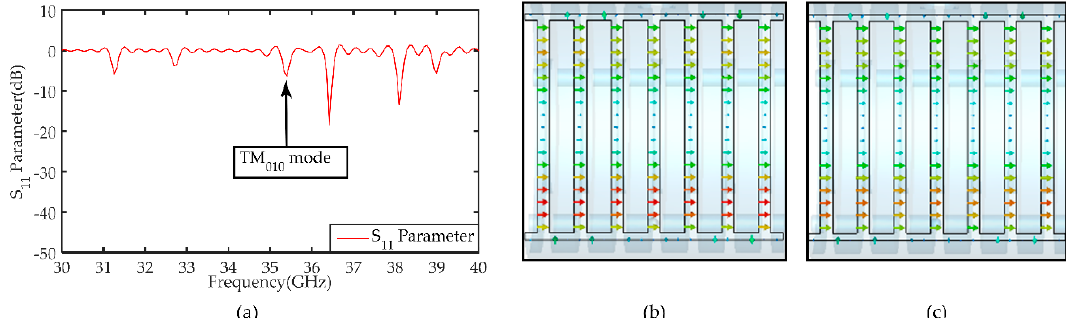
Figure 8. ( a ) Simulated S 11 parameters at the standard waveguide port. ( b ) The field distribution of 2 π mode with dielectric perturbation object and the frequency is 35.3825 GHz. ( c ) The field distribution of 2 π mode with vacuum perturbation object and the frequency is 35.388 GHz.